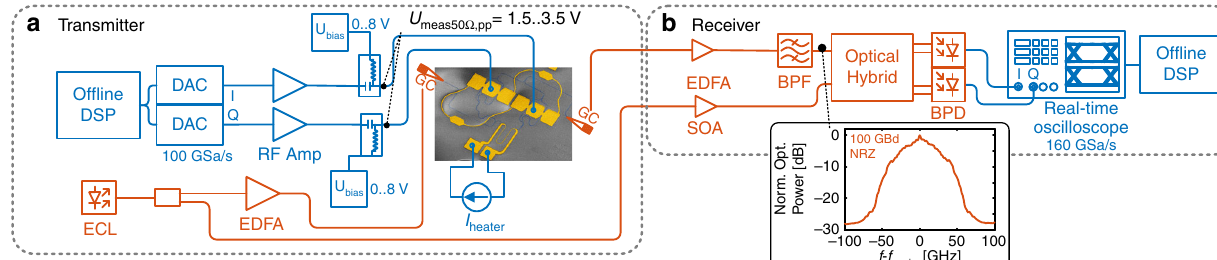
Fig. 5 Experimental setup for high-speed data generation experiment with driving ampli fi